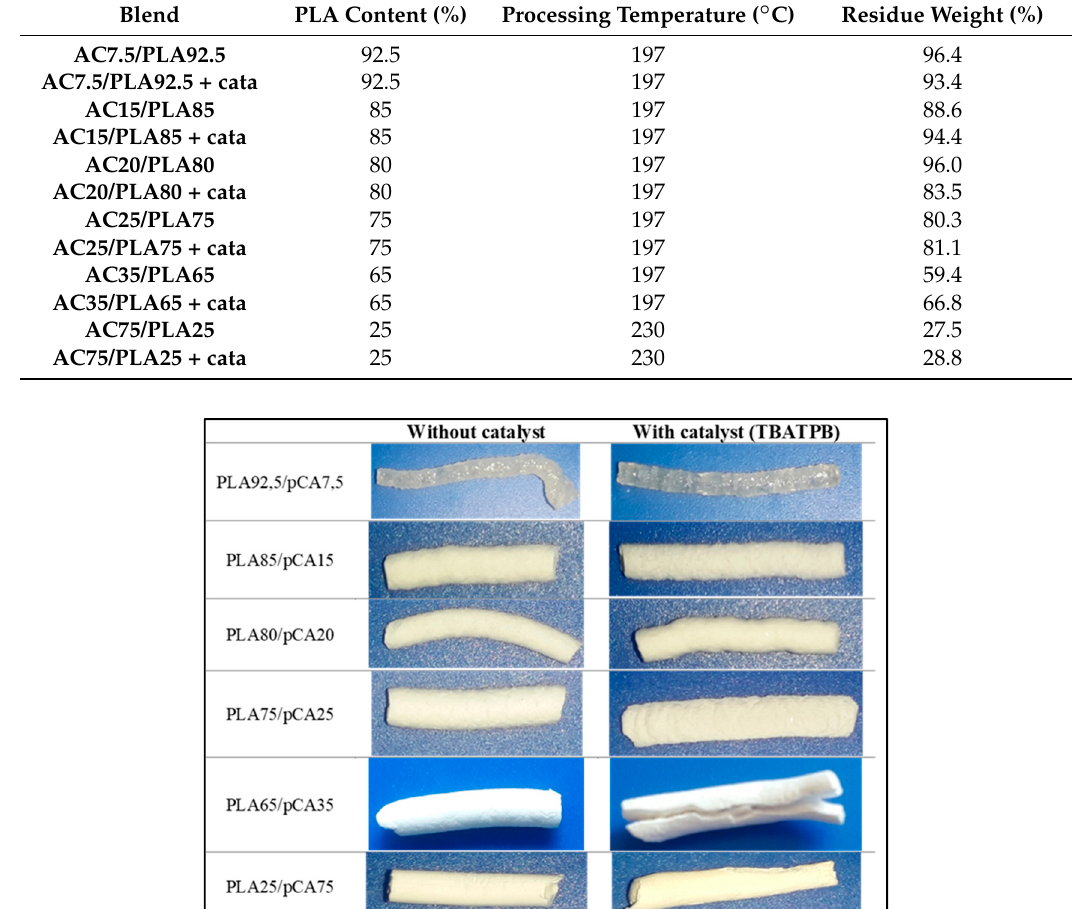
Table 3. Results of dissolution tests performed on extruded strands of blends.